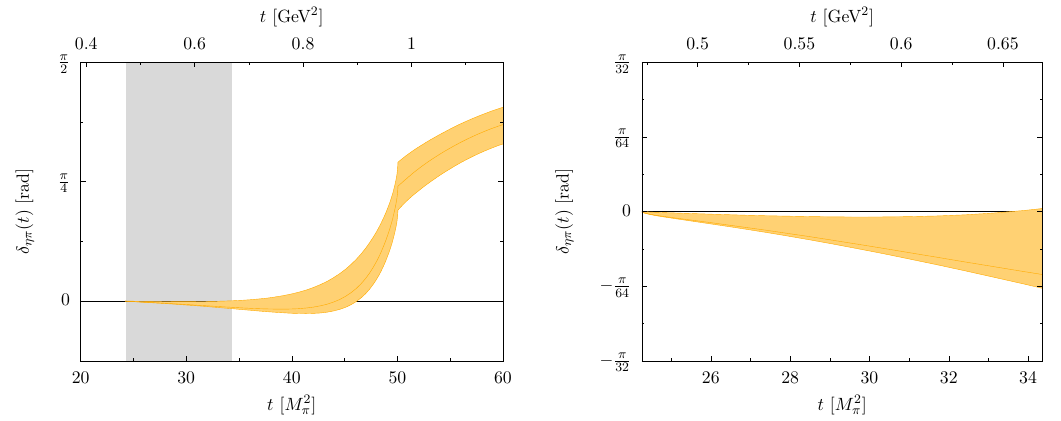
Figure 7 . S -wave ηπ phase shift extracted from refs. [83, 84] including its uncertainty band. Left panel: behavior of the phase shift in the low- and intermediate-energy region. The K ¯ K -cusp is clearly visible at about 50 M 2 . The phase space for η 0 → ηππ is indicated by the gray region. Right π panel: magnification of the physical decay